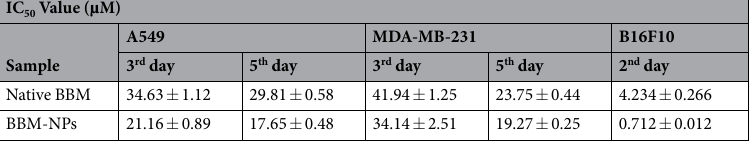
Table 1. IC 50 values of native BBM, BBM-NPs in A549. MDA-MB-231 and B16F10 cell lines through MTT